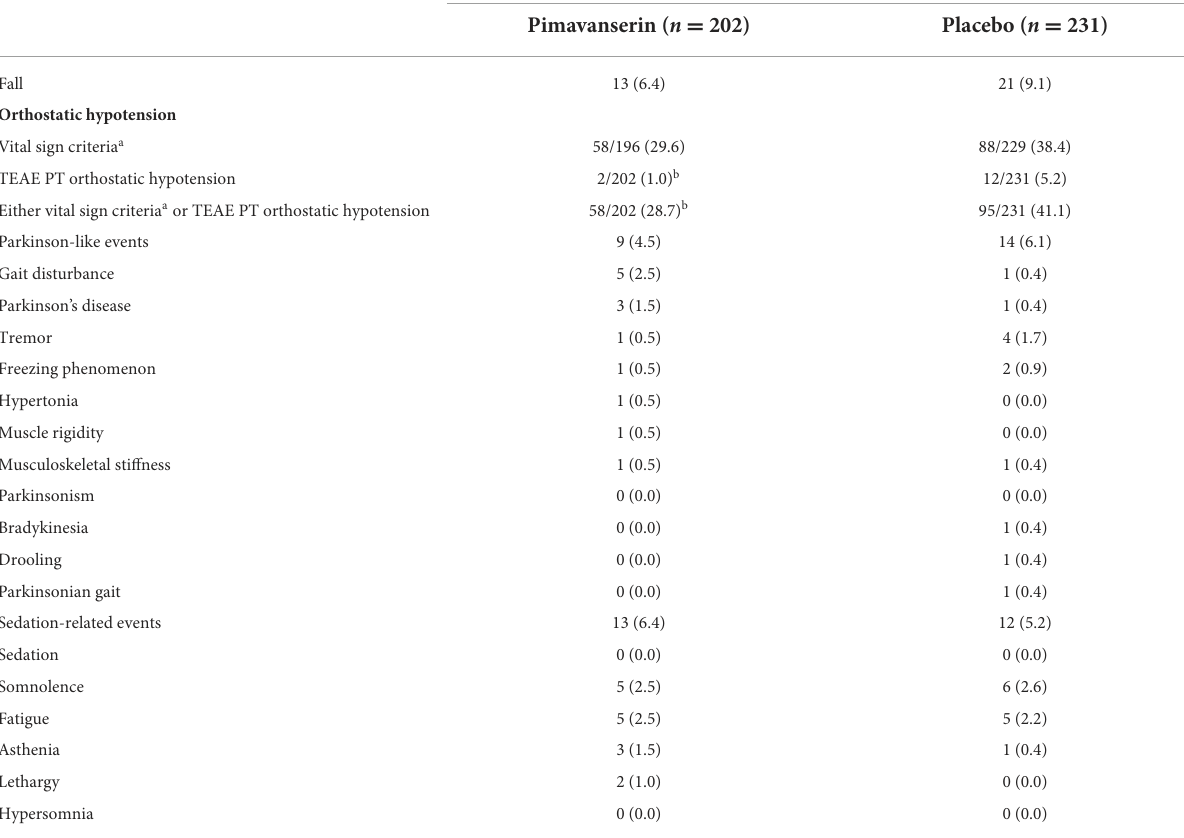
TABLE 2 Motor-related TEAEs, pooled studies 012, 014, 020 (pimavanserin 34mg). Events, n